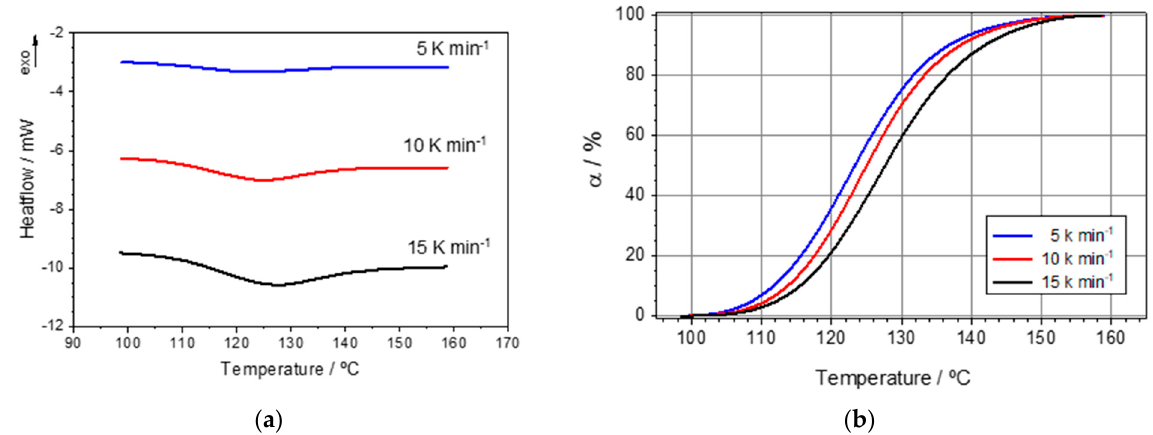
Figure 11. DSC data regarding to the ε→γ transformation at different heating rates ( a ). Evolution of the transformation degree ( α ) with the temperature obtained from the experimental DSC data in Figure 3a ( b ).